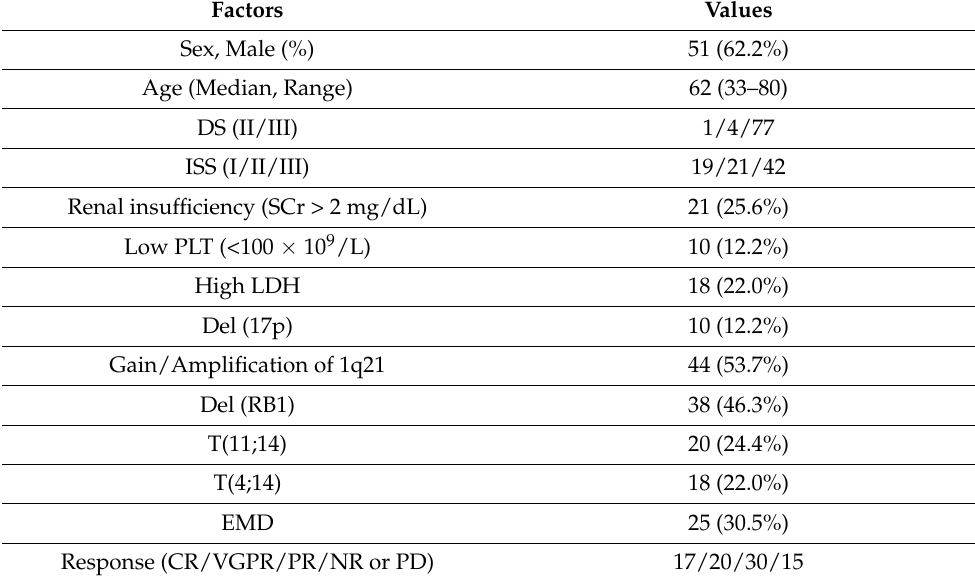
Table 1. Clinical characteristics of 82 NDMM